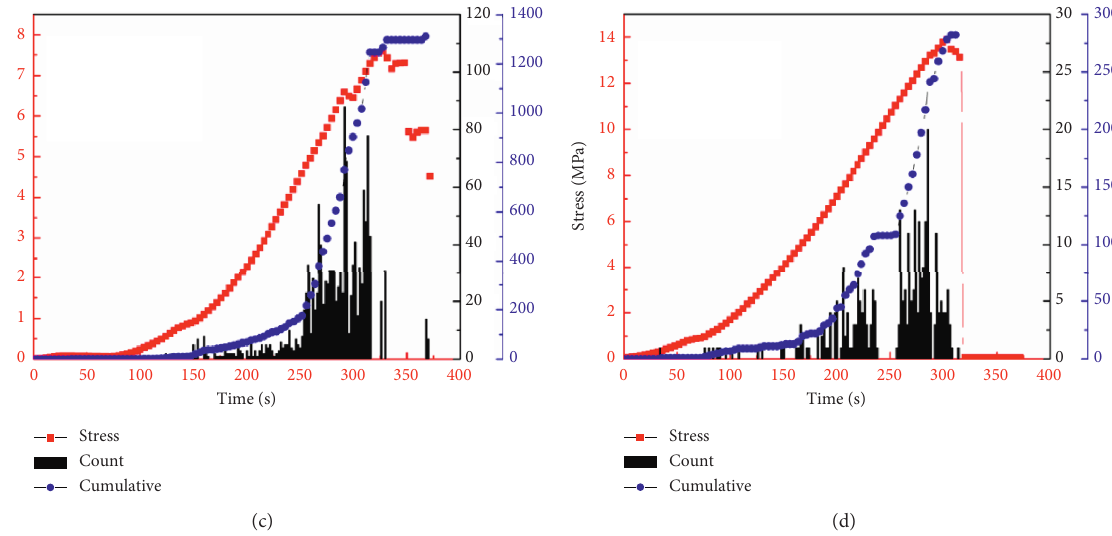
Figure 12: Relationship between AE event, stress, and time (“count” represents AE event count and “cumulative” represents AE cumulative event count). (a) Coal sample no. 0. (b) Coal sample no. 2. (c) Coal sample no. 4. (d) Coal sample no.